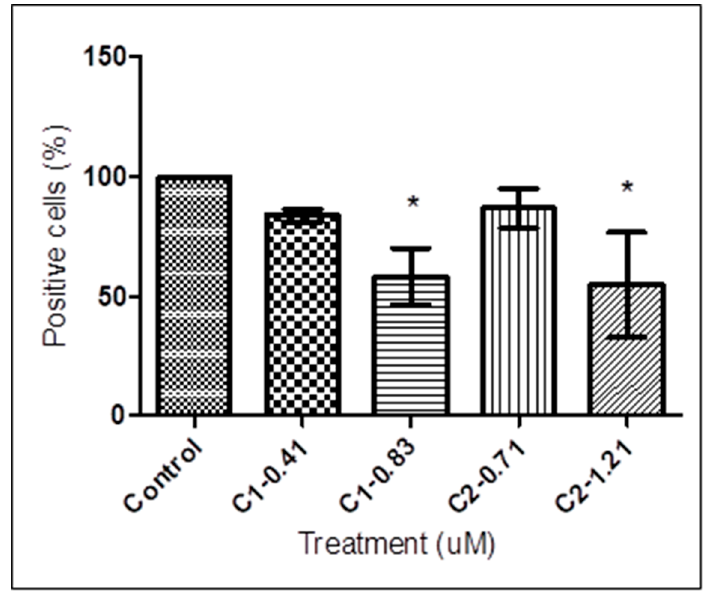
Figure 2. Quantitative analysis of mitochondrial membrane potential of T . b. rhodesiense . Treated and untreated trypanosomes were exposed to 1 at 0.41 and 0.83 μ M, and 2 at 0.71 and 1.21 μ M for 72 h, stained with potentiometric probe MitoTracker Red (100 nM) for 15 min and analyzed by flow cytometry. Trypanosomes treated with 0.41 and 0.83 μ M of 1, and 0.71 and 1.21 μ M of 2 resulted in the reduction of MitoTracker Red positive cells from 99.74 ± 0.11% (control) to 83.92 ± 2.68%, 58.31 ± 11.75%, 86.83 ± 8.19%, and 54.65 ± 22.04%, respectively. Data are presented as means ± SD from triplicates over three other independent experiments. The asterisks indicate significant differences between the treated and untreated groups calculated by one-way ANOVA with Tukey post-test (* p < 0.05). C, compound.